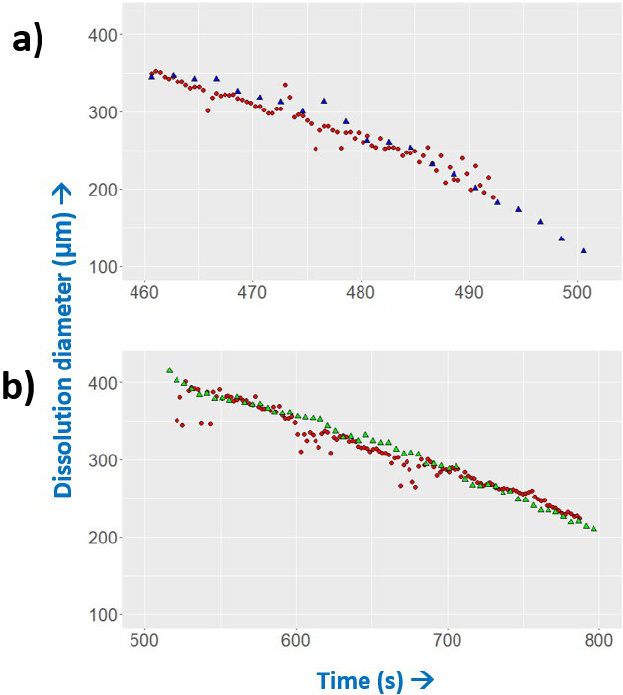
Figure 9. Plot showing the diameters of the ( a ) silica and ( b ) alumina inclusions during its dissolution in the slag. The red circles are the diameters as calculated by the image processing program. The blue and green triangles represent the manually measured diameters of the silica and alumina inclusion,